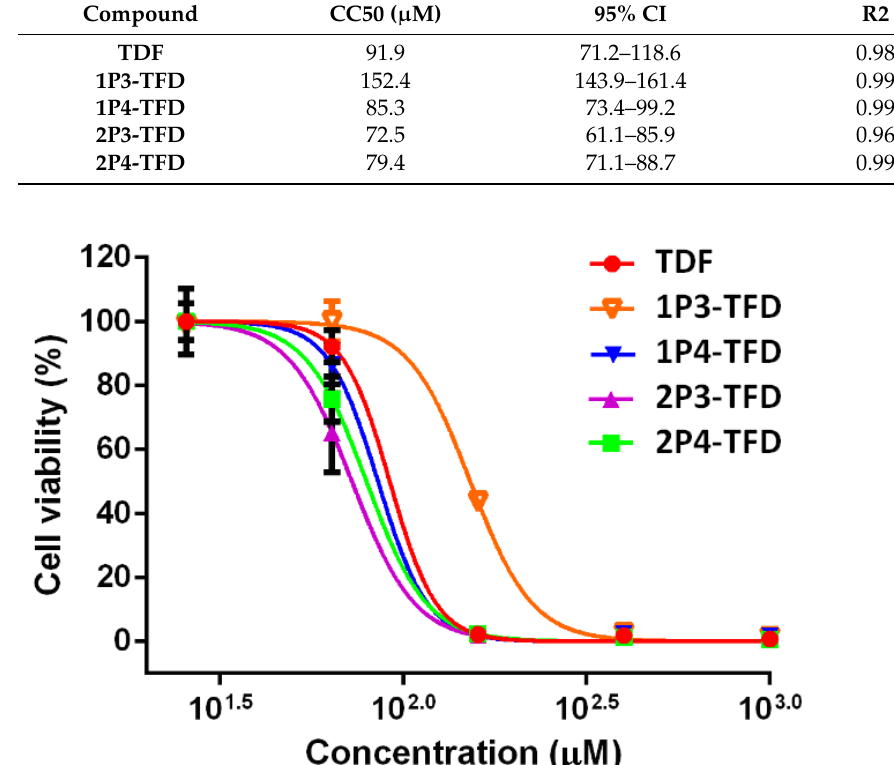
Figure 2. Cytotoxicity of TDF and TFD adducts. MT-4 cells were incubated with the compounds for 72 h, after which viability was determined using the MTT test. For TDF, absorbance values corresponding to 100% viability were obtained by culturing untreated cells; in the case of the adducts, the cells were cultured in the presence of equivalent concentrations of the corresponding mPEG- b - PEPA